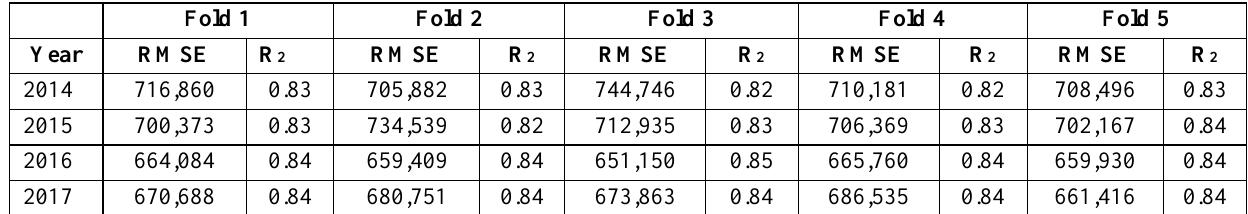
Table 8: GBM Cross Validation Summary